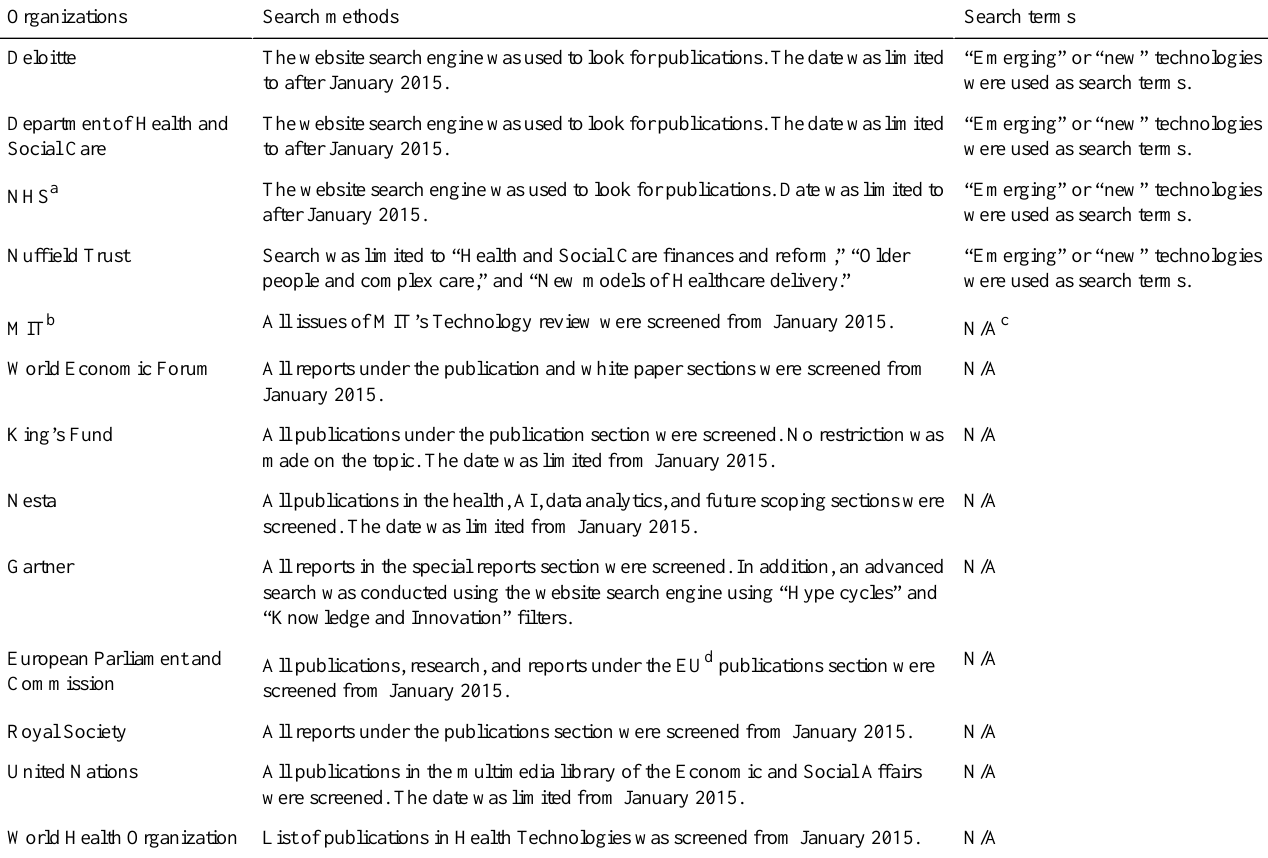
Table 1. Search strategy conducted on websites of key